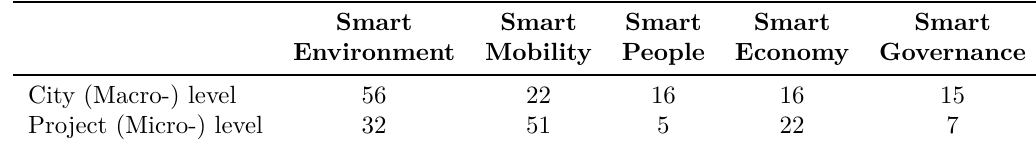
Table 1. Total number of KPIs defined for each of the